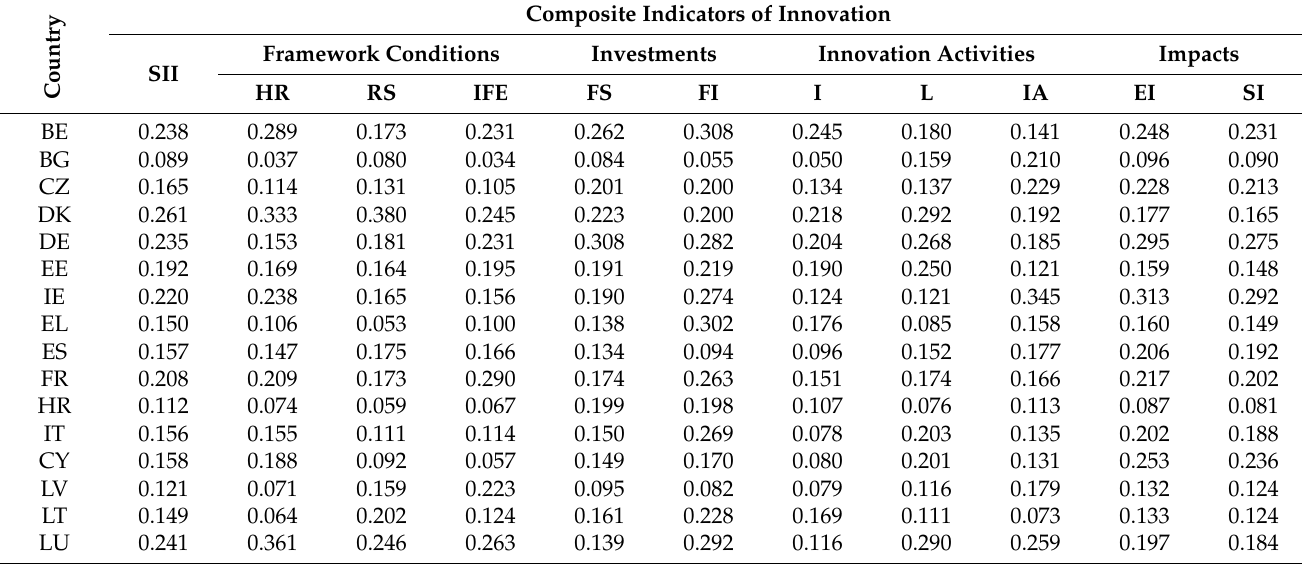
Table 7. Key innovation indicators 2018—EU countries—normalization